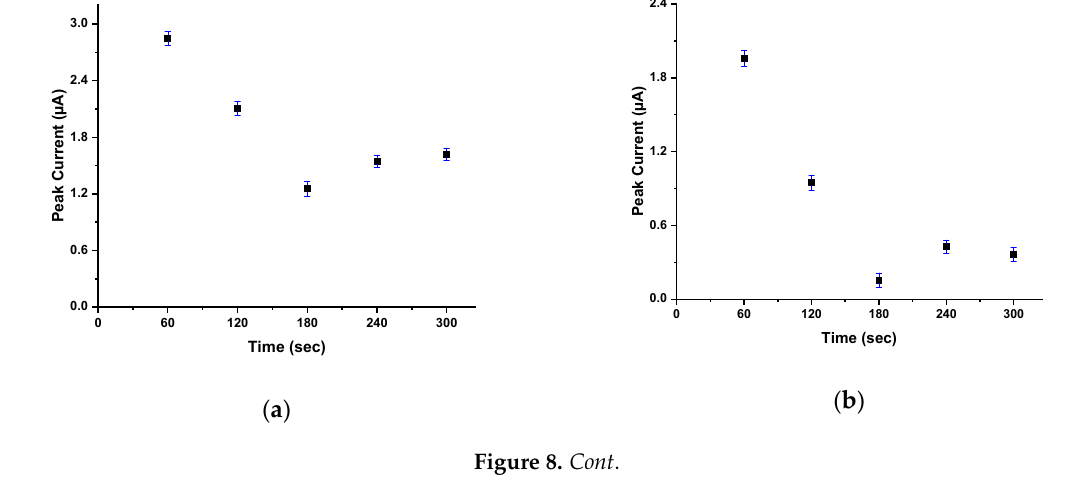
E(V) ( c ) Figure 8. The effect of the binding time of 0.5 ppm DOX on the signals of ( a ) dGuo and ( b ) dAdo; and ( c ) DP voltammo ‐ grams of dsDNA/PtNPs/AgNPs/SPE (black) with a different binding time of DOX in pH 4.70 AB; 60 s (pink), 120 (blue), 180 s (red).